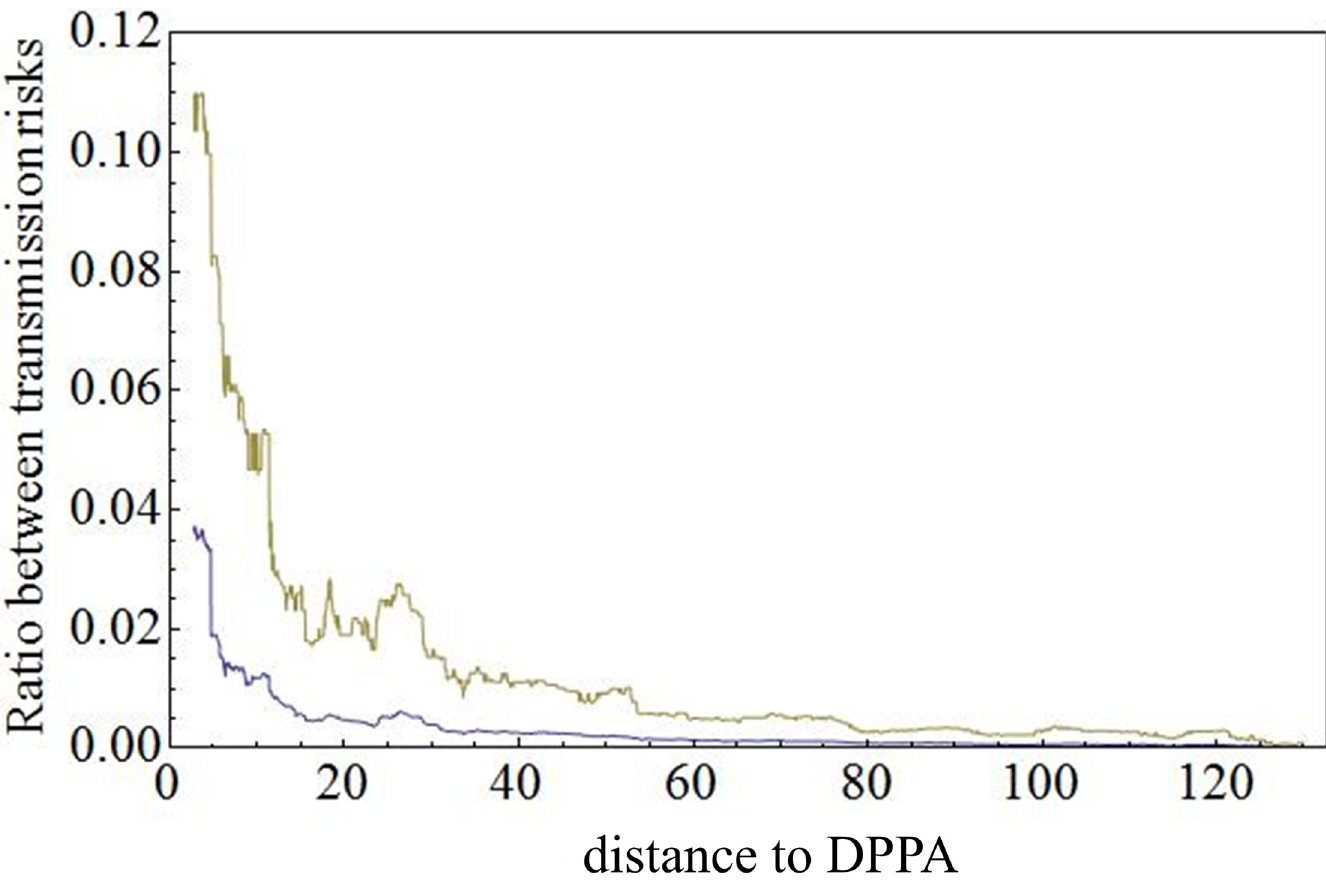
Fig 4. Risks of HPAI transmission jumps expressed as ratio between ‘triple-event’ transmission via the compartment and ‘single-event’ transmission, as function of the distance of the compartment farm to the nearest farm in the DPPA (here Gelderse Vallei, in the central part of the Netherlands). Shown is a rolling average plot calculated with an averaging window of 5 km., based on a set of 10,000 pairs {distance, ratio} (see M&M section). The rolling average of the mean (blue line) and 95% percentile (green line) are presented. The 5% percentile is equal to 0